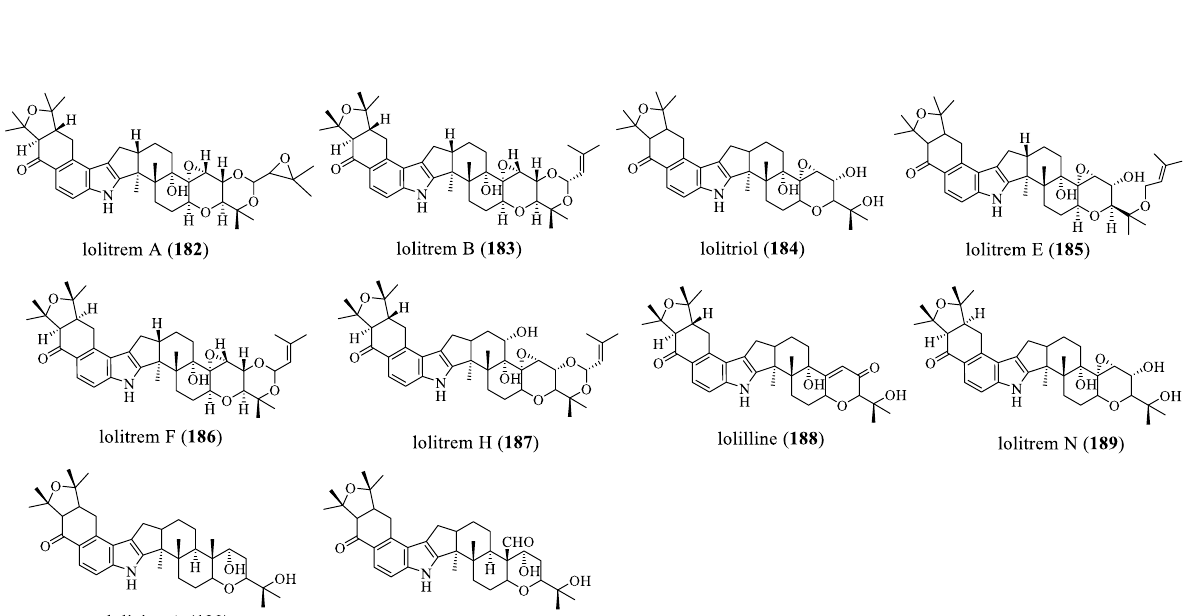
Fig. 12 Chemical structures of paspaline‑type compounds with A‑ring 5/6 member